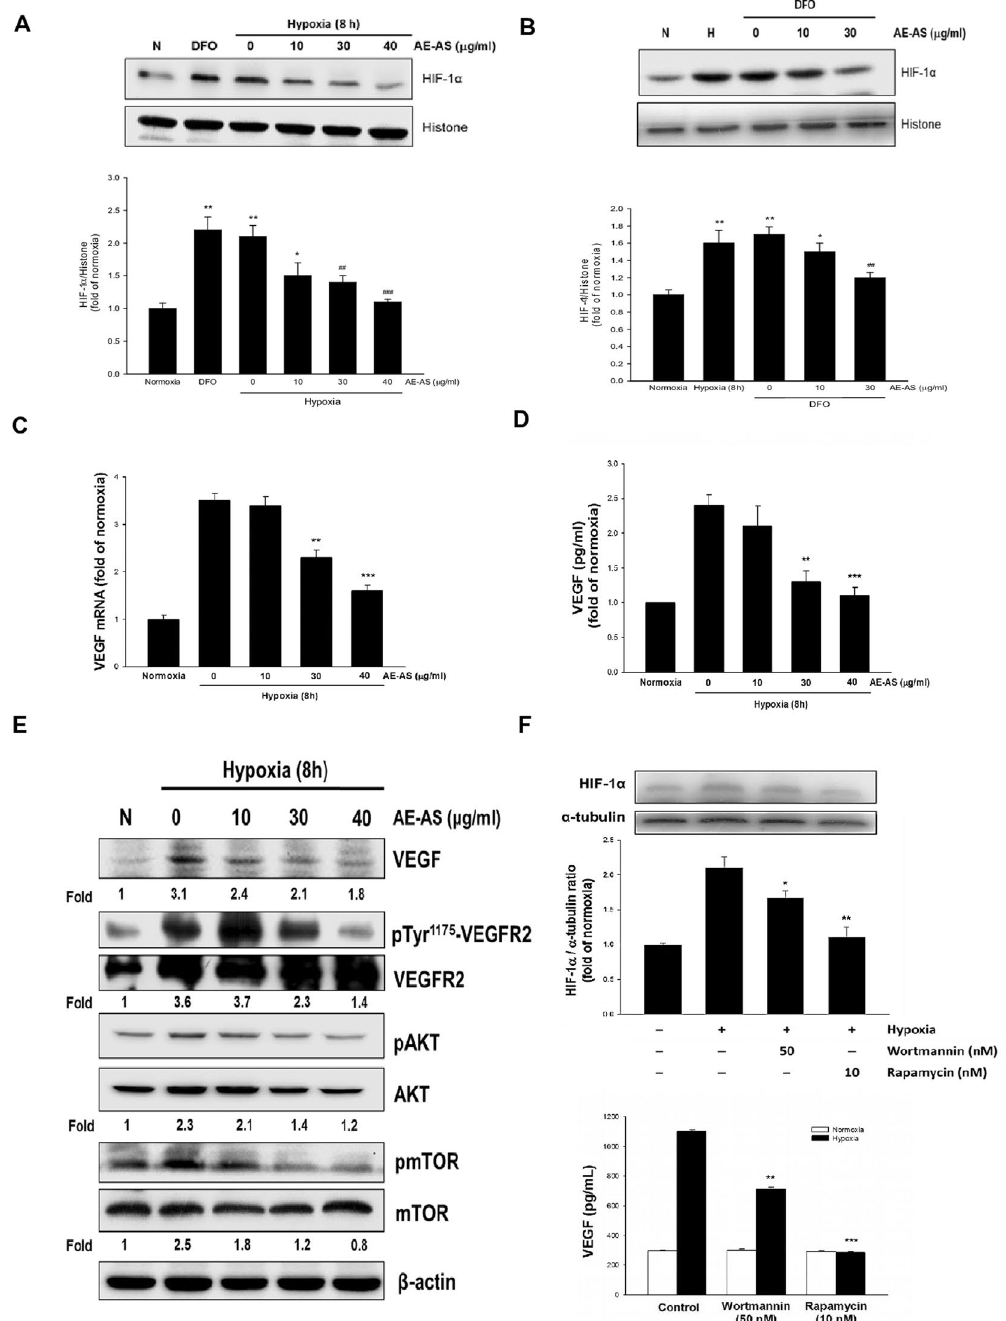
Figure 2. AE-AS reduced HIF-1 α level, VEGF expression/secretion, and downstream signaling pathways in hypoxic T24 cells. The nuclear protein level of HIF-1 α under hypoxia ( A ) or DFO treatment ( B ), VEGF mRNA ( C ), VEGF secretion ( D ), and related target gene expression ( E ) in various groups were analyzed. Data was expressed as mean ± SEM (n = 5). ** P < 0.01, *** P < 0.001 versus normoxia-treated group, ## P < 0.01, ### P < 0.001 versus respective untreated group. The T24 cells were pretreated with rapamycin (10 nM) or wortmannin (50 nM) for 1 h followed by exposed to hypoxia for 8 h, and the HIF-1 α protein expression and VEGF secretion were determined (F). * P < 0.05, ** P < 0.01, *** P < 0.001 versus hypoxia-treated alone